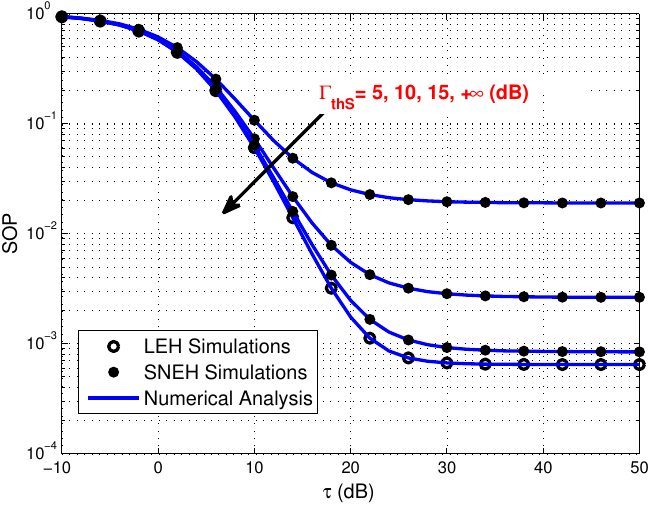
Figure 6. Secrecy outage probability versus τ for LEH and SNEH under various Γ th _ S , where Γ th _ S = { 5,10,15, + ∞ }